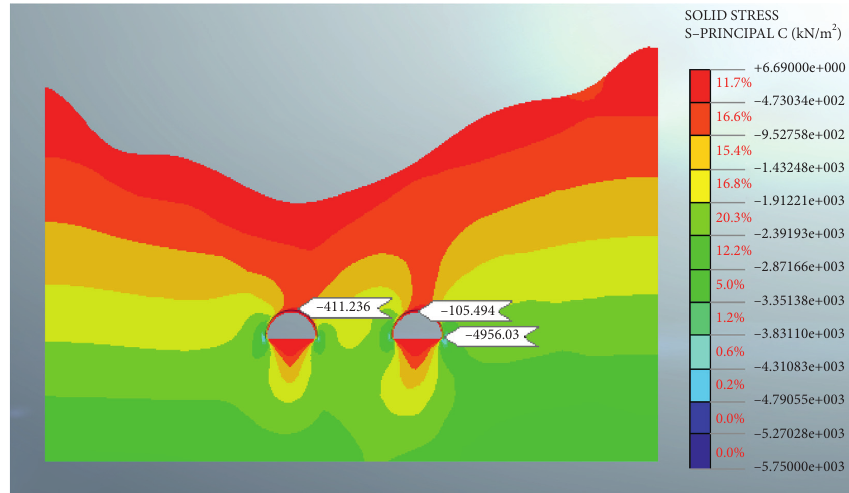
Figure 25: Distribution of large principal stresses in surrounding rocks in three-step method.